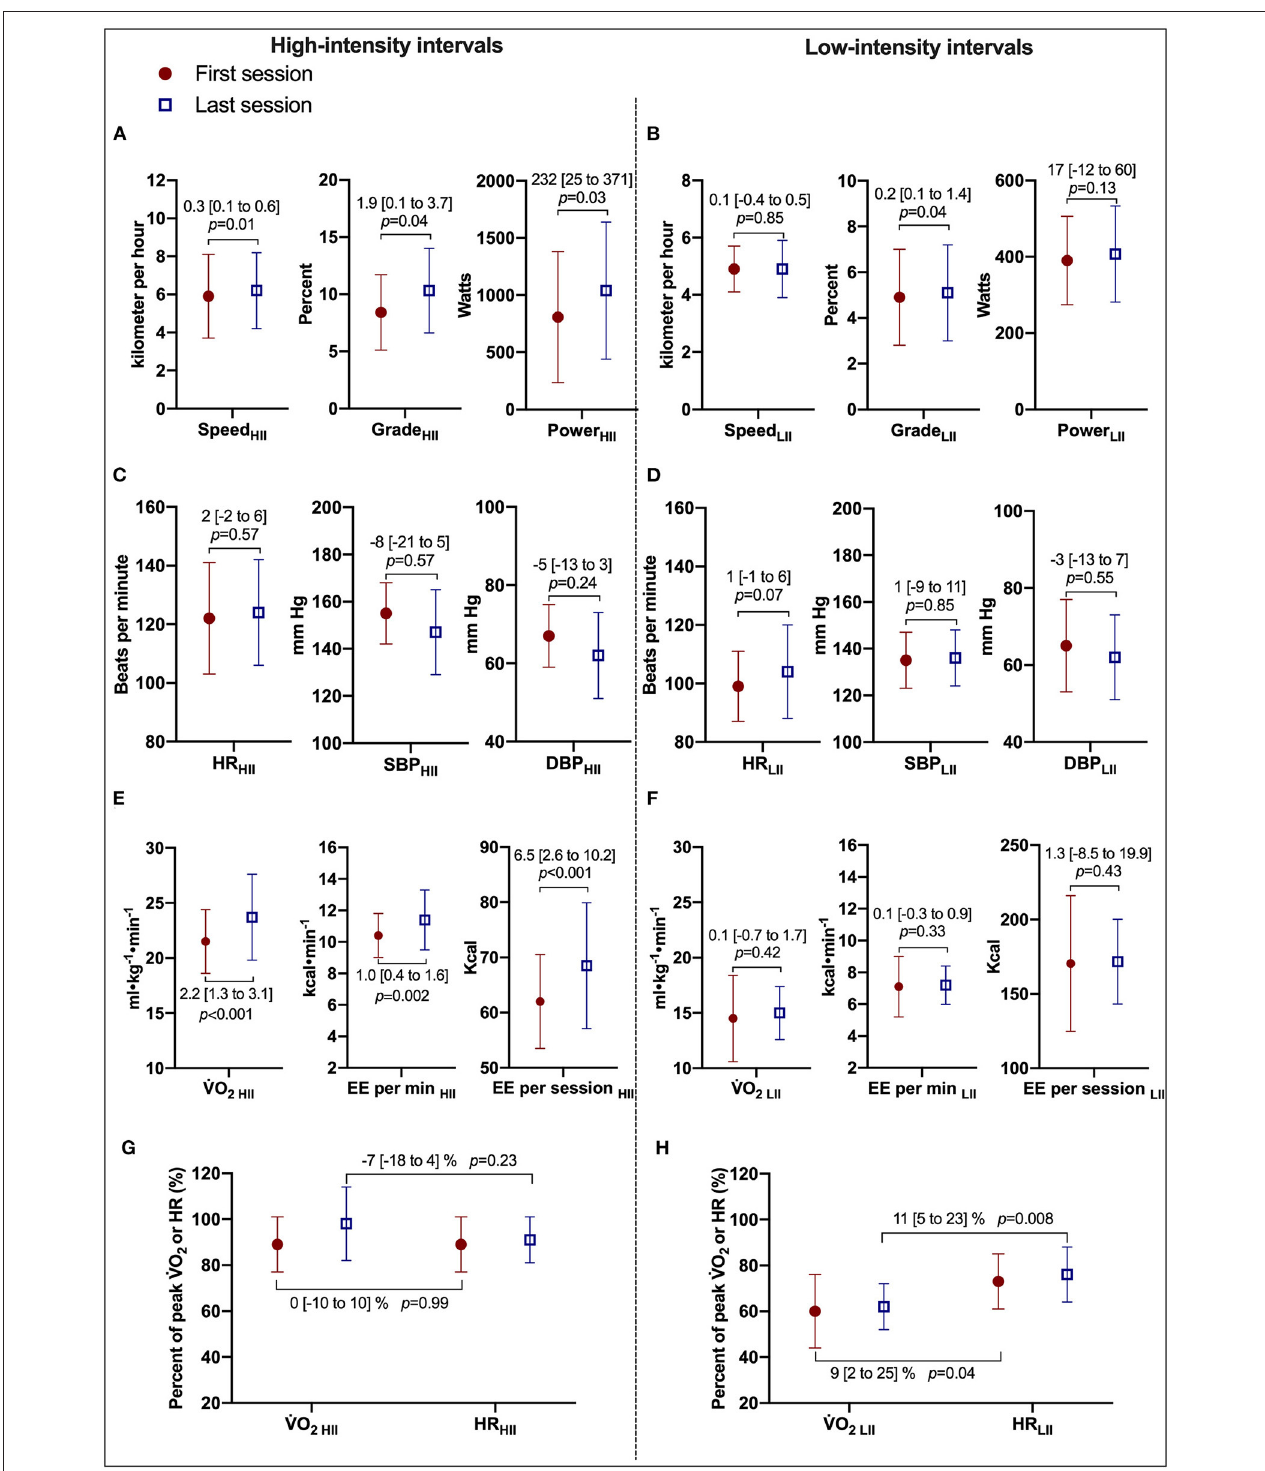
FIGURE 2 | Cardiorespiratory and treadmill workload adaptations to RPE-prescribed HIIT. (A,B) Present comparisons of treadmill speed, treadmill grade, and power output between the first and last HIIT sessions during high- and low-intensity intervals, respectively. (C,D) Present comparisons of heart rate (HR), systolic (SBP), and diastolic (DBP) blood pressure between the first and last HIIT sessions. (E,F) Present comparisons of oxygen uptake (˙VO 2 ), energy expenditure (EE) per minute, and per session. (G,F) Present the changes in the relationship of %˙VO 2peak and %HR peak between the first and last HIIT sessions during high- and low-intensity intervals, respectively. HII is high-intensity interval. LII is low-intensity interval. Repeated-measures ANOVA was used for all assessments. Data were expressed as mean difference [95% confidence interval].